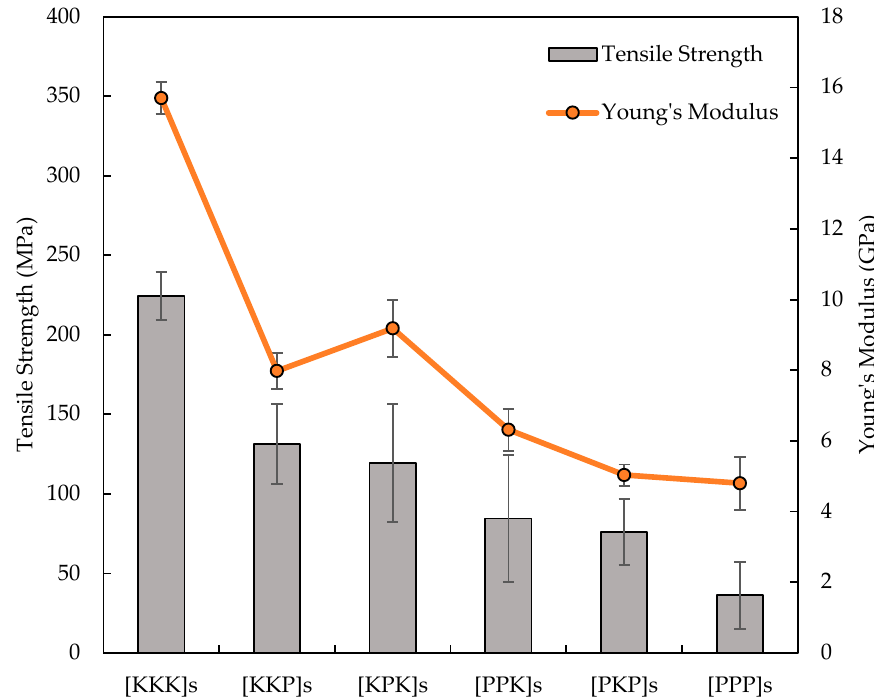
Figure 7. Tensile strength and Young’s modulus of PALF/Kevlar-reinforced UP hybrid composite laminates with different stacking sequences.